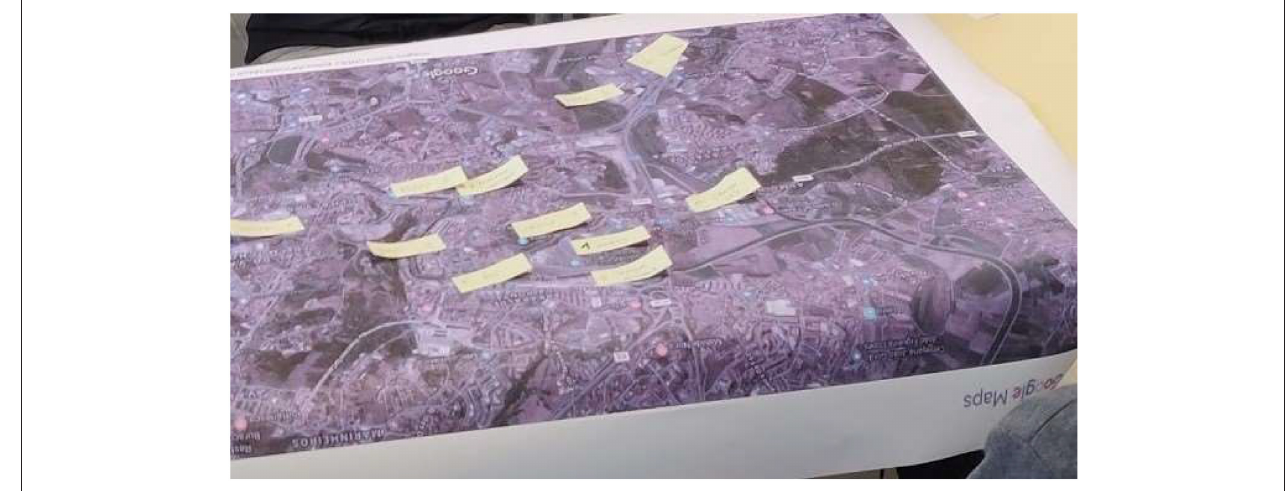
FIGURE 2 | Game play of the first game.